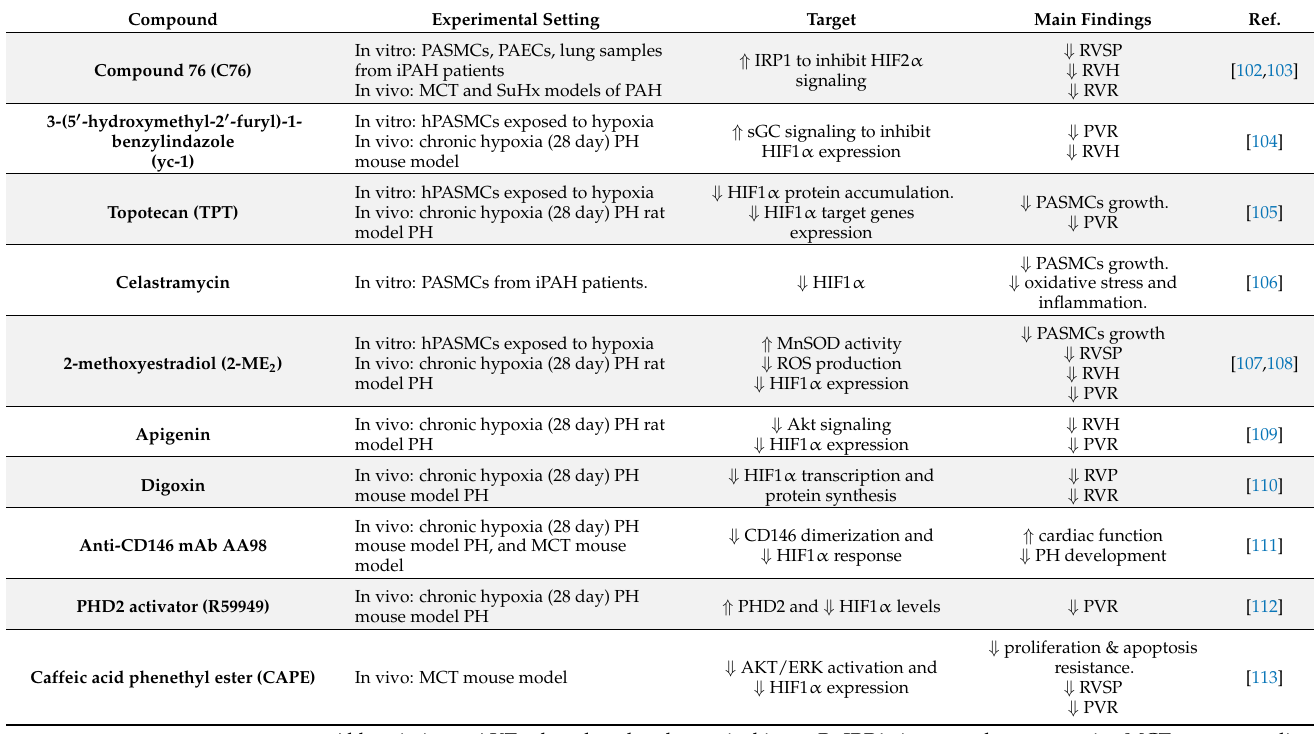
Table 1. Preclinical studies that utilized various therapeutic strategies targeting HIF signaling in PH